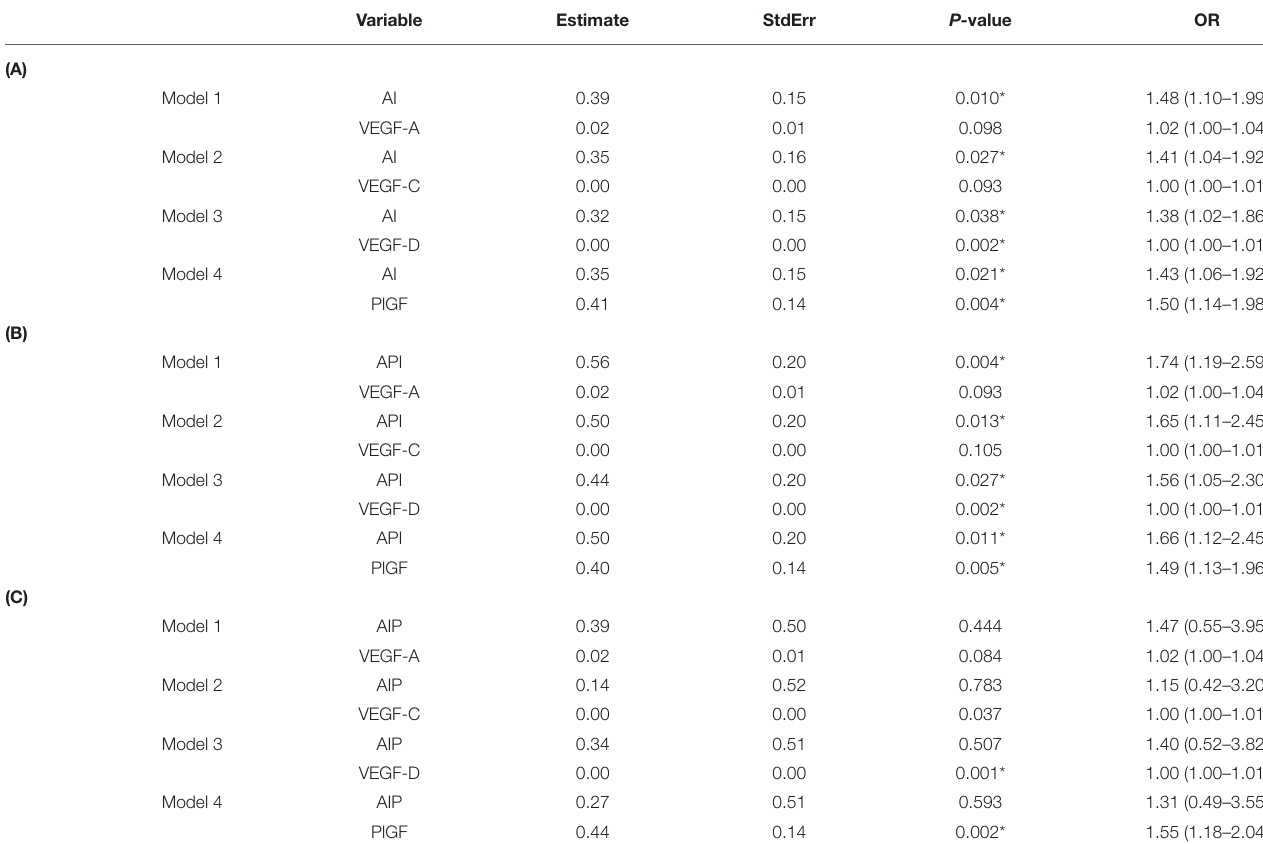
TABLE 4 | Multiple ordinal logistic regression models showing that AI and API contributed to the occurrence and severity of DR asscociated with elevated circulating level of VEGF-D and PIGF. Variable Estimate